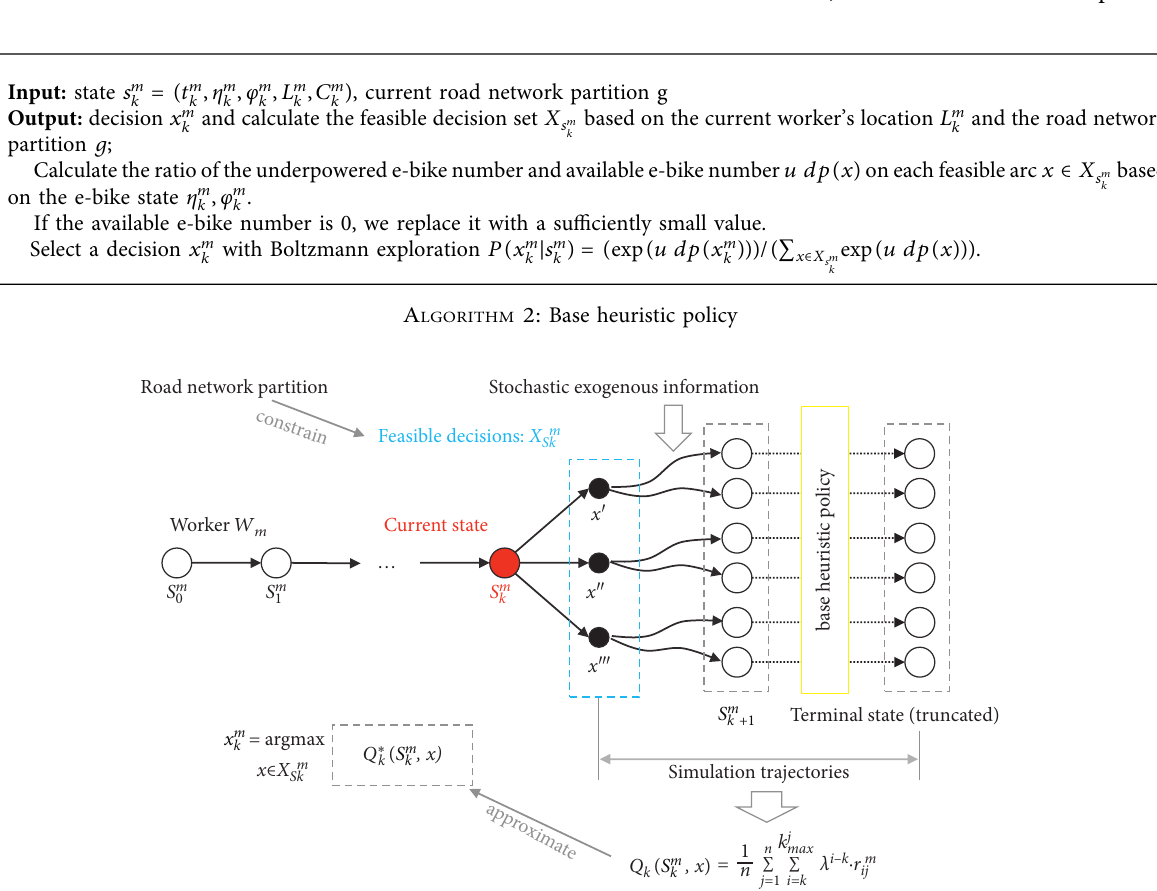
Figure 6: A lookahead policy with rollout